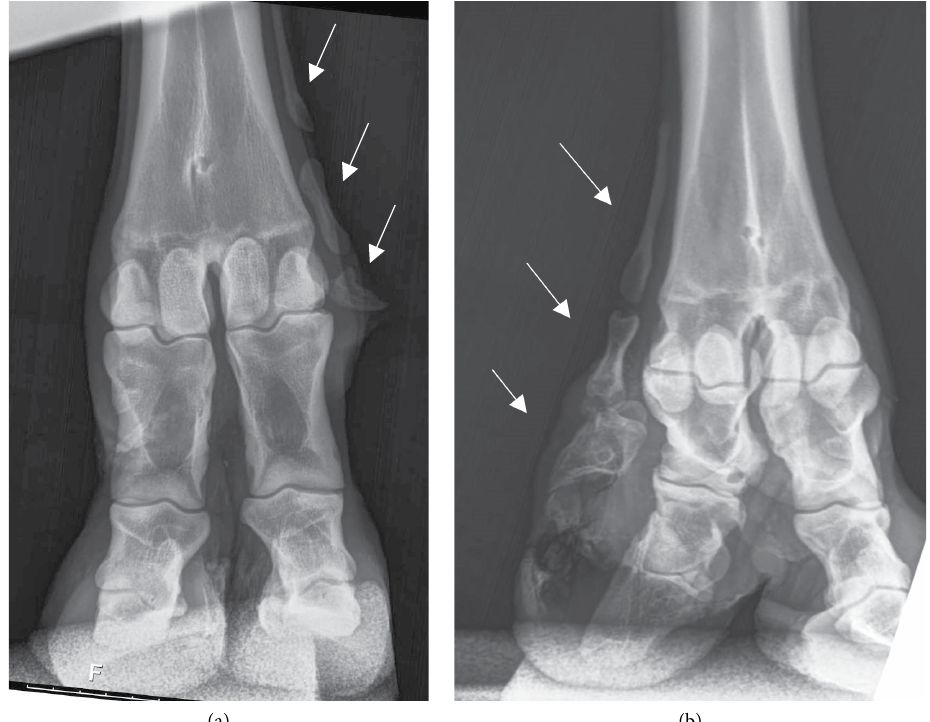
Figure 3: Palmodorsal radiographs of the front feet of Dexter cow Case 1 at 35 mo of age. (a) Left front foot. (b) Right front foot. Both feet presented segmented bone development (shown by the arrows) indicating an extra digit next to the medial digits. Arrows indicate extra bone development. The extra digit structure on the right foot extended to the area of the third phalanx. The extra digit structure on the left foot extended to the area of the sesamoid bones and dew